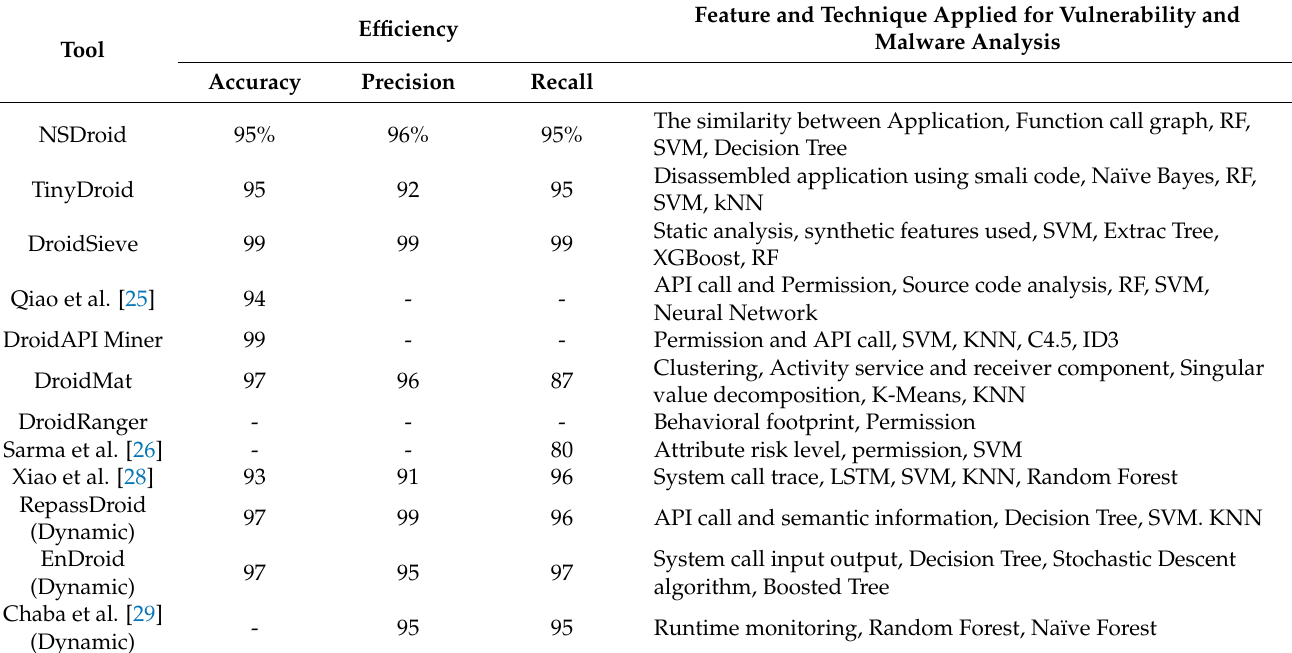
Table 3. Recapitulative table, where RF stands for Random Fo22rest, and Dynamic tool is prescribed by the keyword